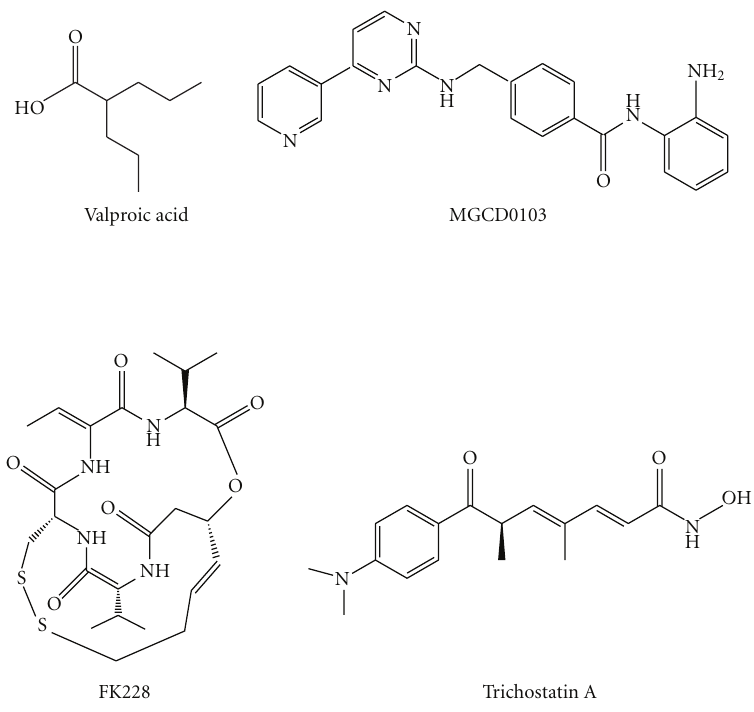
Figure 1: Chemical Structures of Representative Inhibitors of Class I/II HDACs. While structurally diverse, they share one common feature: the existence of active groups targeting the zinc-dependent catalytic sites of class I/II